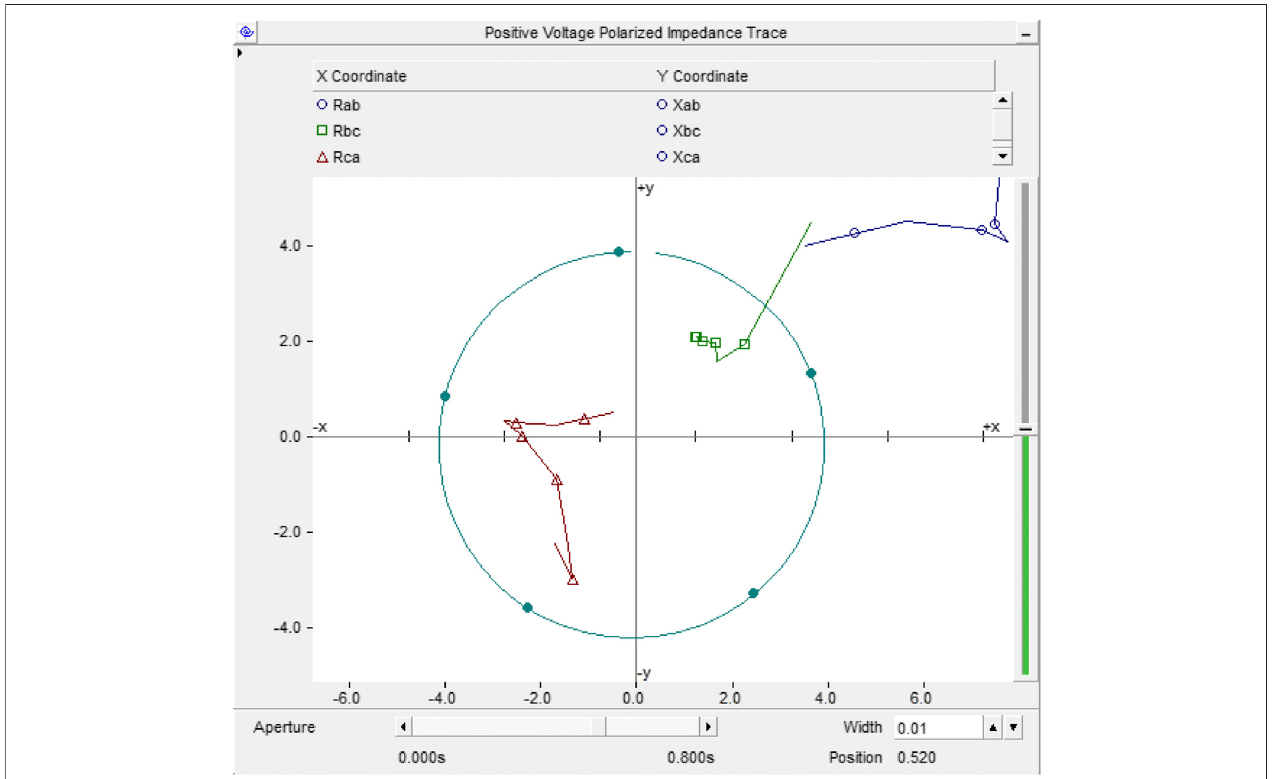
FIGURE6| Whentheprotectionisatthesendingend,thePCCisdisconnectedfromthegrid.Themeasuredimpedancetrajectoryandoperationcharacteristicsof the positive sequence voltage fault component polarized impedance relay at a BC phase fault with a fault resistance (2 Ω ) at 2.5 km forward.